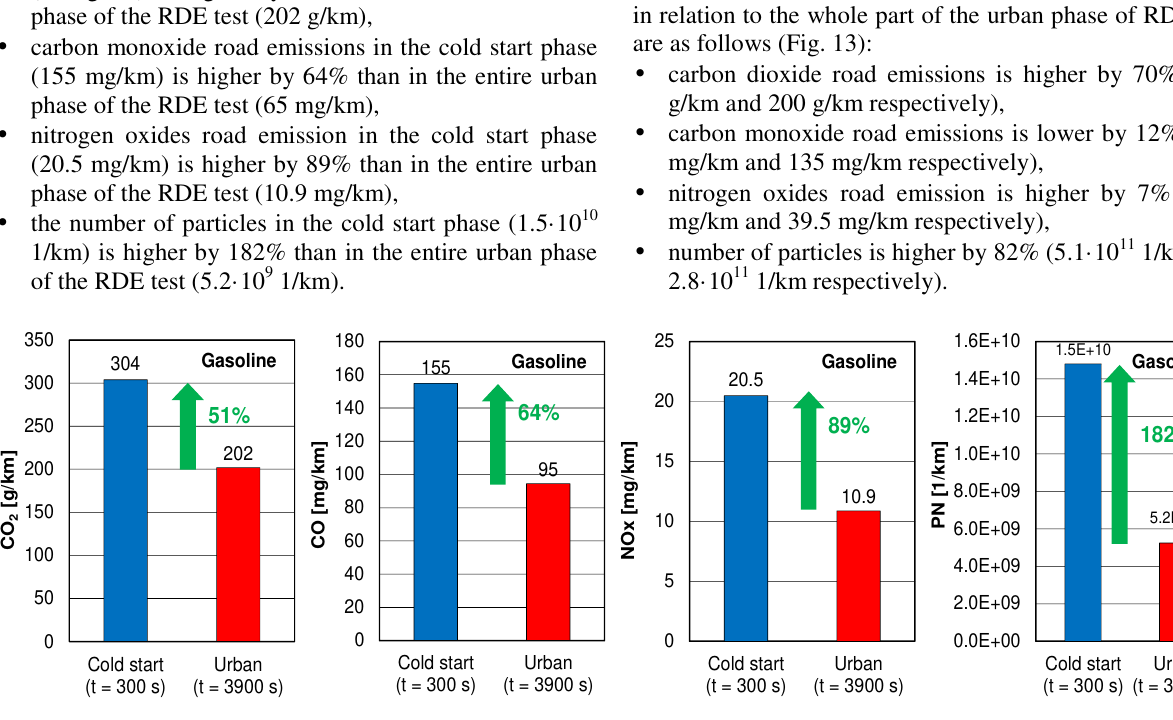
Fig. 12. Road emissions of carbon dioxide, carbon monoxide, nitrogen oxides and particles number during cold start of gasoline engine